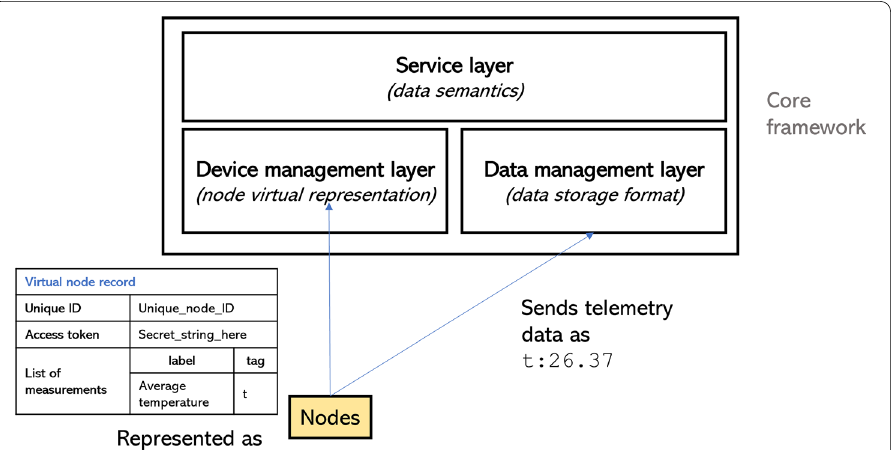
Fig. 2 Label and tag in IoT TeleHub virtual node